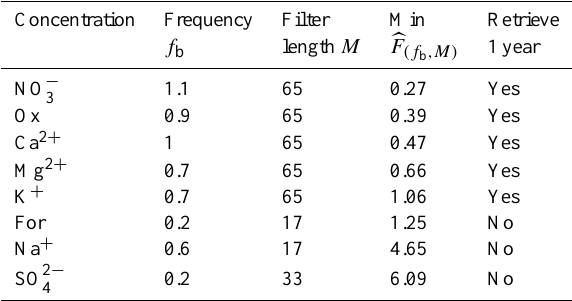
Table 2. Comparison of nitrate, oxalate, calcium, magnesium, potassium, formate, sodium, and sulfate (from top to bottom, re- spectively), in terms of dating